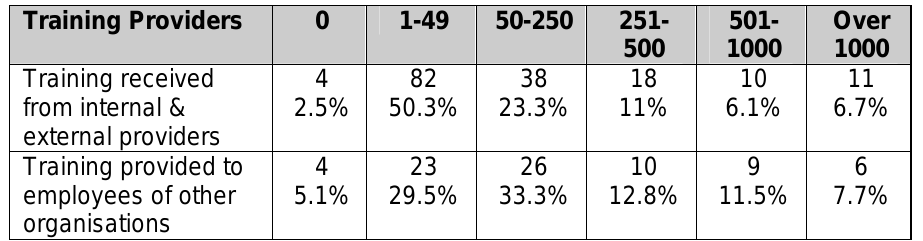
Table 1: Number of employees trained during one